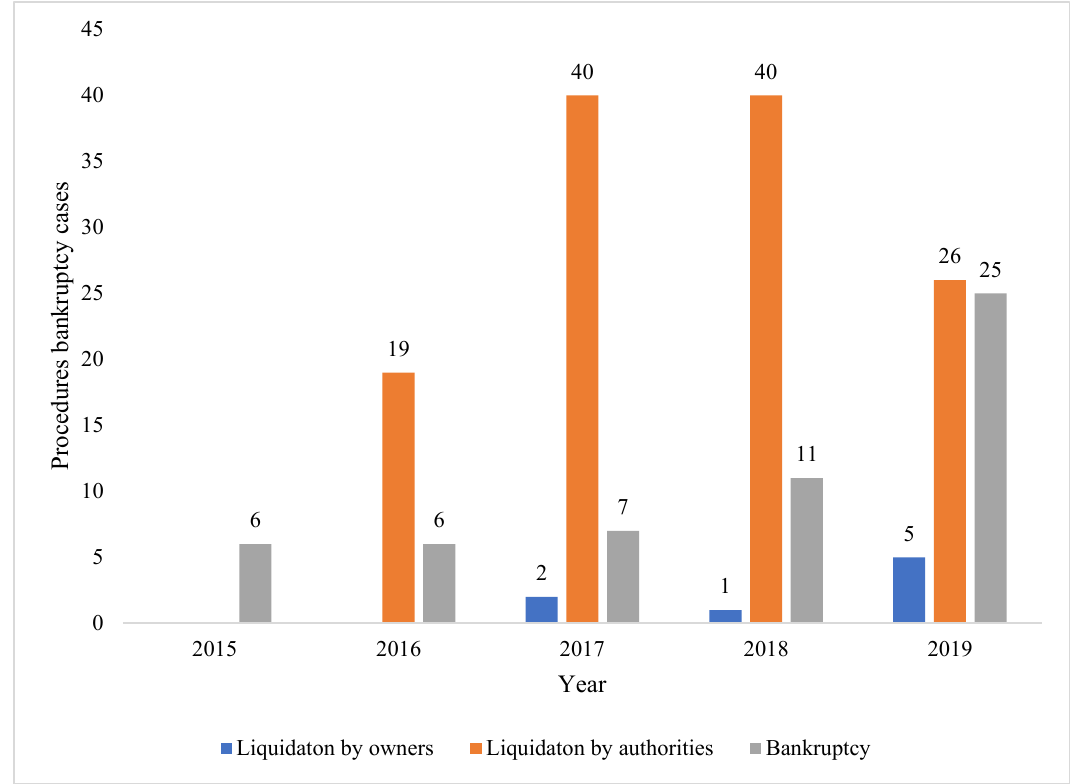
Figure 4. Procedures of bankruptcy cases in brokers and banks in 2015–2019.